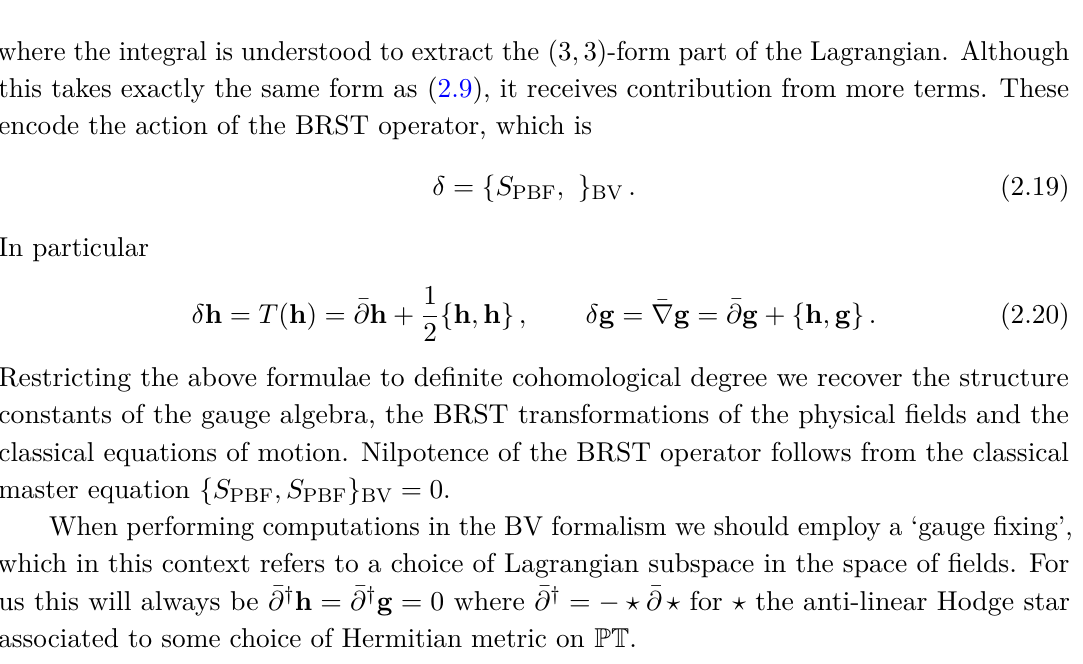
Table 1 . Quantum numbers of w, ˜ w